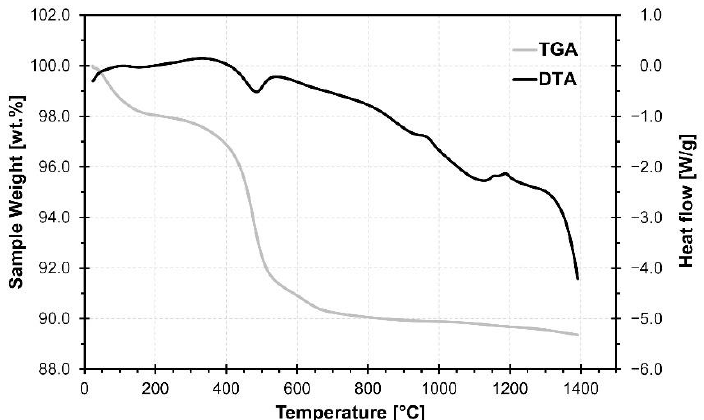
Figure 3. Results of TG/DTA analysis of waste diatomaceous